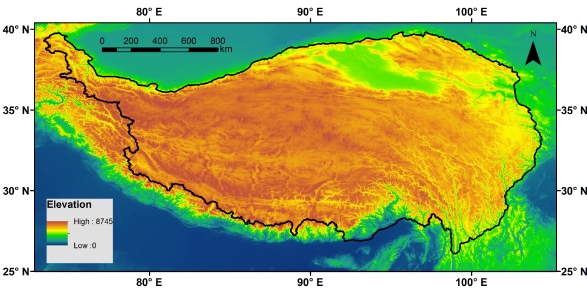
Figure 1. Map of the location and topography of the Tibetan